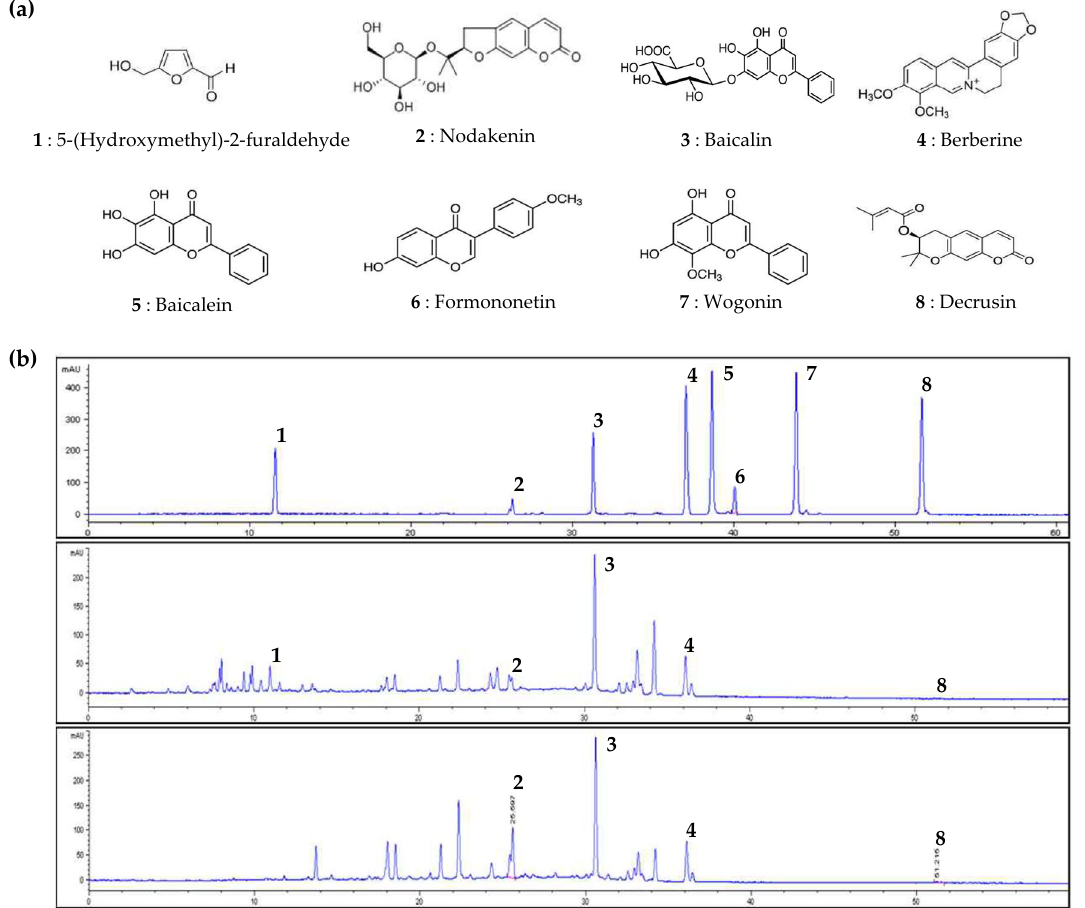
Fig. 1 The structures of eight compounds and HPLC analysis data of DYT extract. The HPLC chromatograms of the standard mixture 0.2 mg/mL, λ 254 nm ( b , top panel). The extracted DYT sample 1.0 mg/mL, λ = from ARG was confirmed at 330 nm ( b , lower